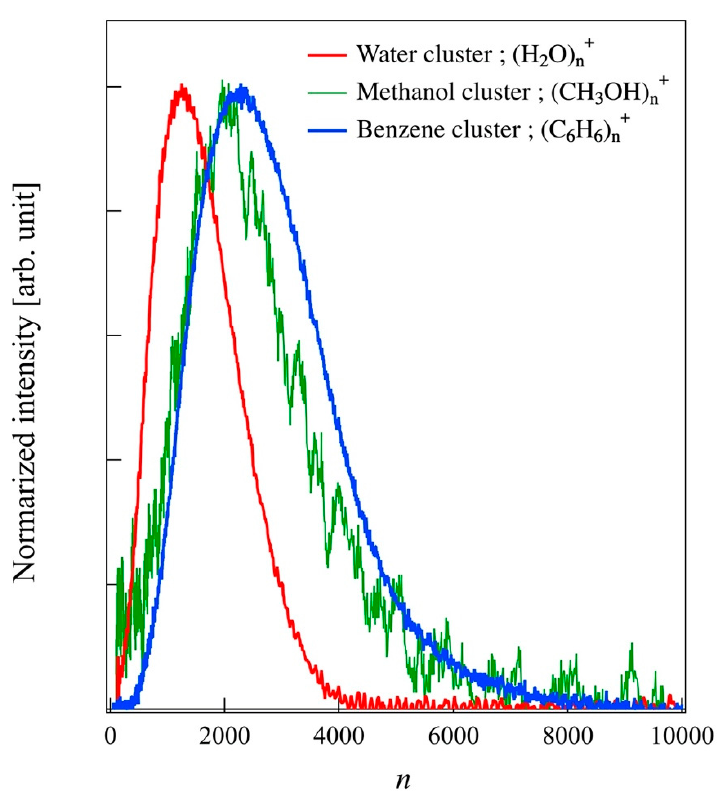
Figure 4. Size ( n ) distribution of water, methanol, and benzene cluster ion beams at an Ar flow rate of 180 sccm before size selection.